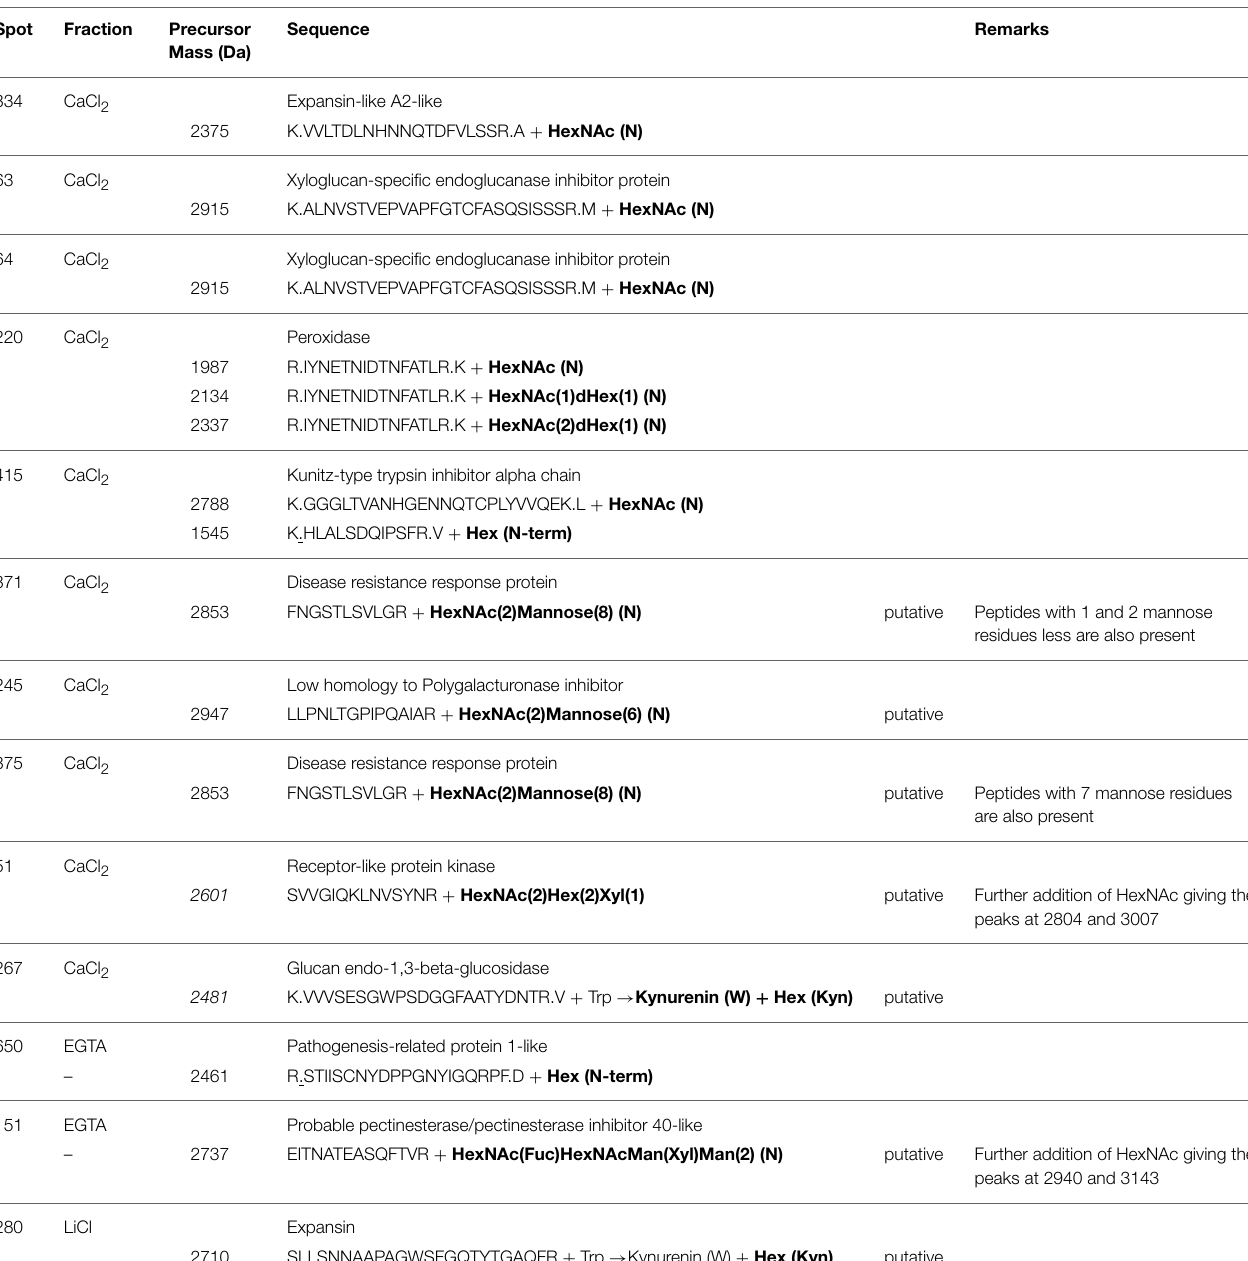
TABLE 5 | MALDI-TOF/TOF identification of some glycosylation events detected in the fractions of the hybrid